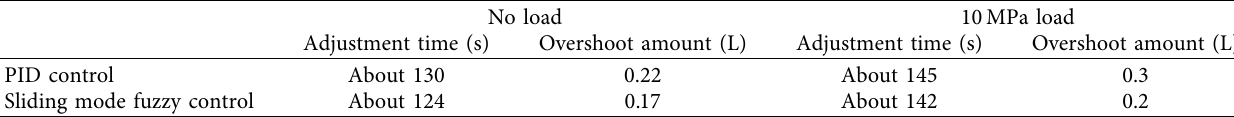
Figure 12: Experimental results of different control methods under 10MPa load. Table 3: Experimental results of different